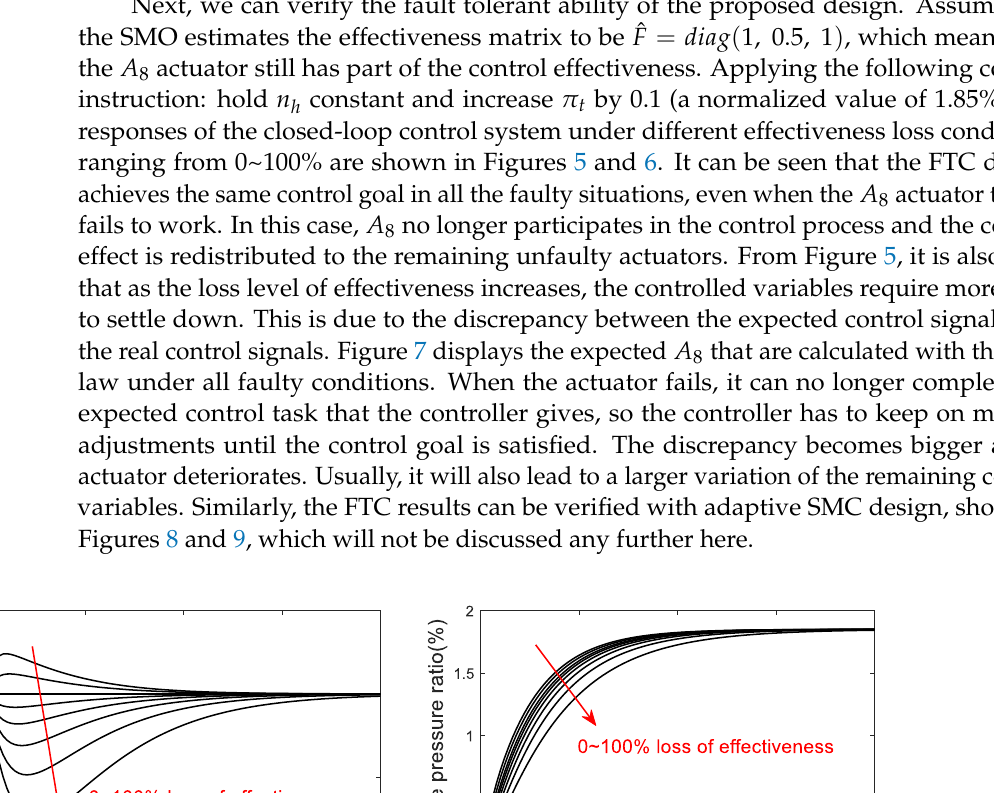
( c ) Figure 6. FTC result of SMC design-control variables. ( a ) 125 A . Figure 7. Expected nozzle throat area of